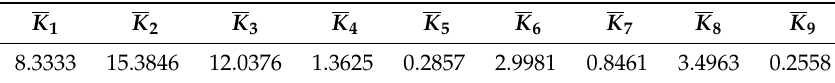
Table 2. The expected number obtained by MVA and FES algorithms.